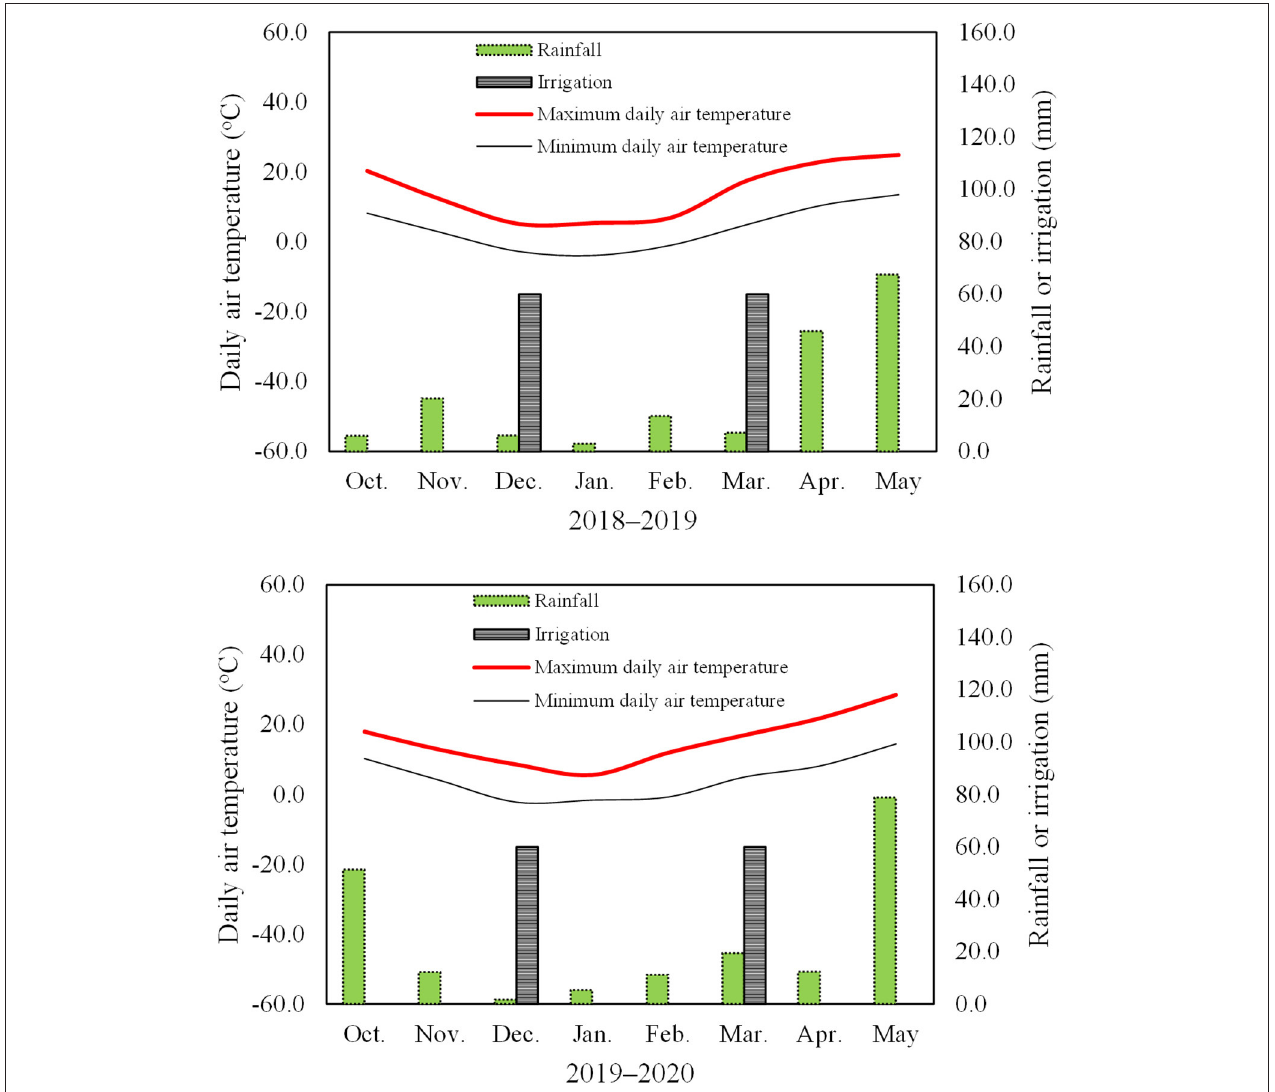
FIGURE 1 | Maximum and minimum daily air temperatures at 2m, rainfall amount, and irrigation in the two wheat growing